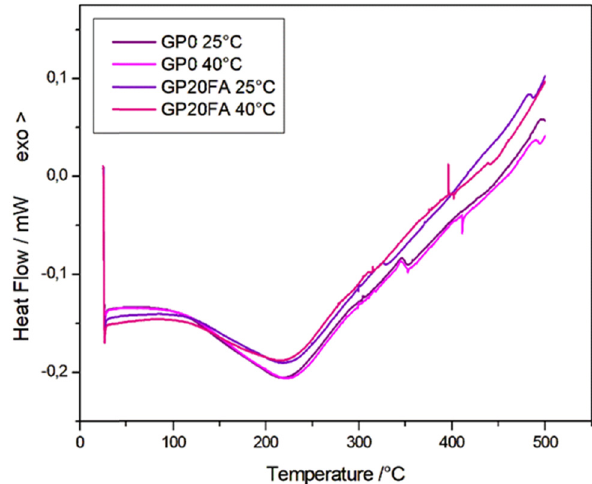
Figure 6: TG degradation curves, in nitrogen fl ow, for GP0 at 25°C,